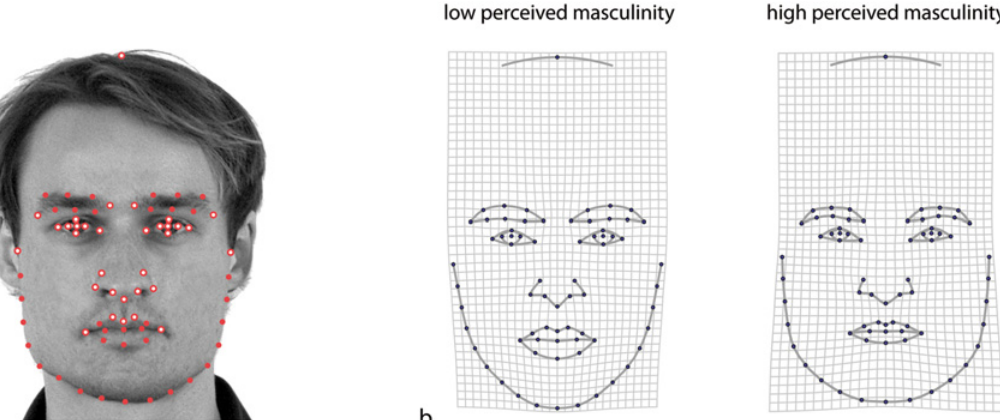
Fig 3. Landmark configuration used for studying face shape and perceived masculinity. (a) Face with the 33 landmarks (open circles) and 37 semilandmarks (filled circles) used in the morphometric analysis. (b) The shape features determining perceived masculinity are visualized by deformation grids from the mean shape to shapes predicted for deviations of ± 20 rating scores from the